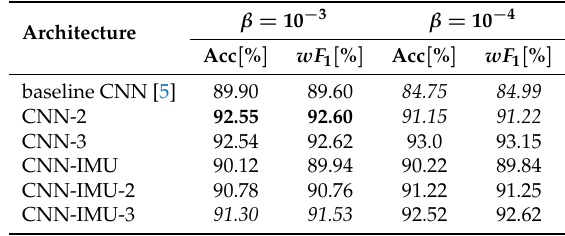
Table 10. Validation accuracies and Weighted F1 for the architectures on the Pamap2 dataset using two learning rates during training.